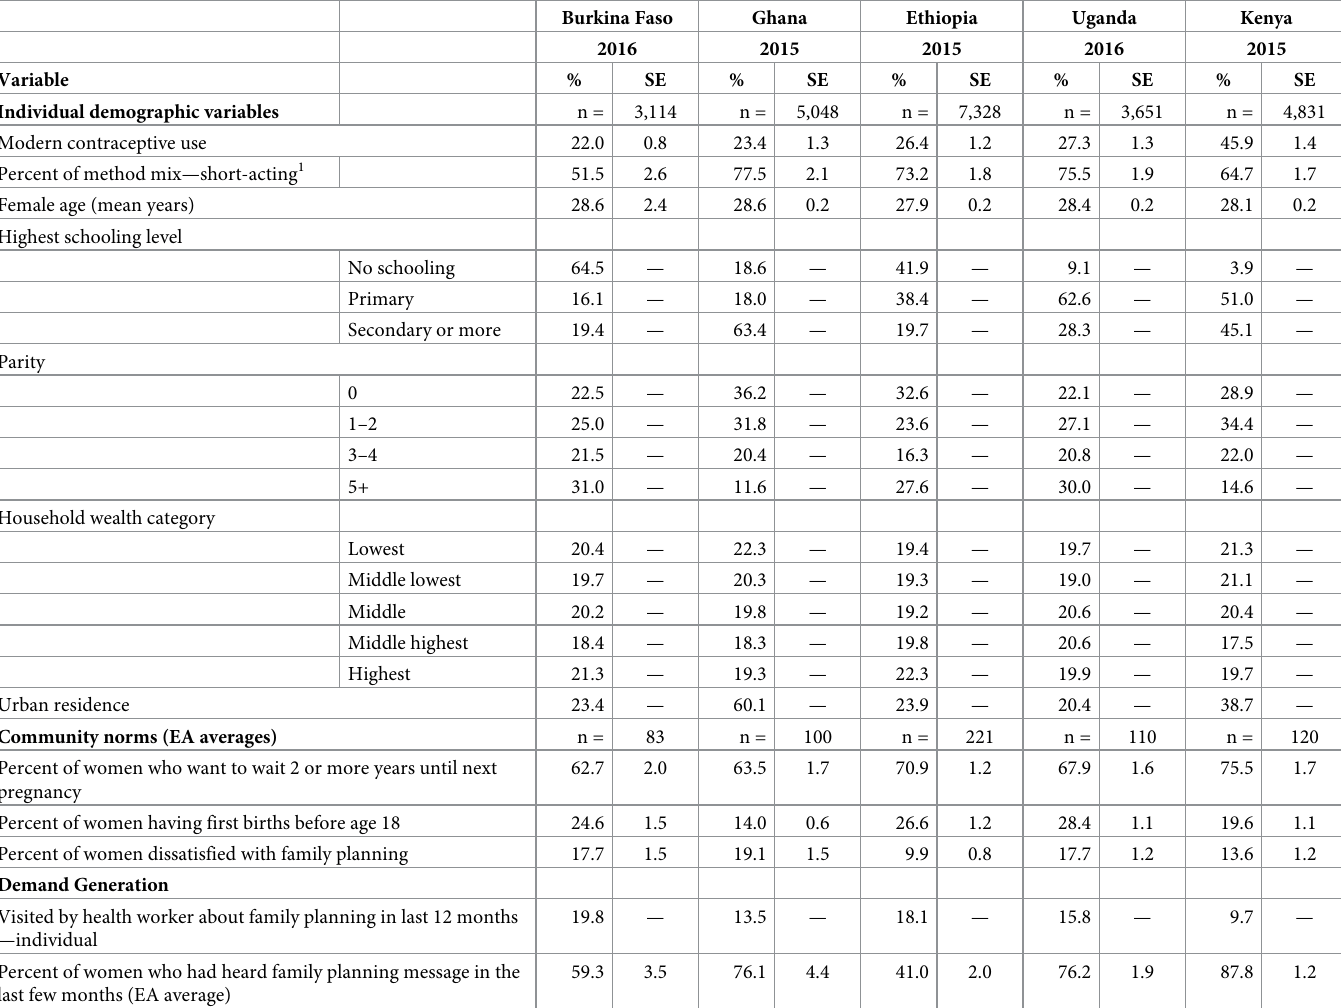
Table 1. Sample composition by variable type and country: Females age